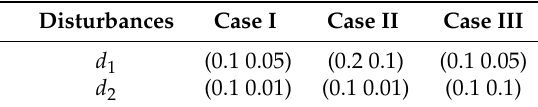
Table 3. Disturbance parameter settings.